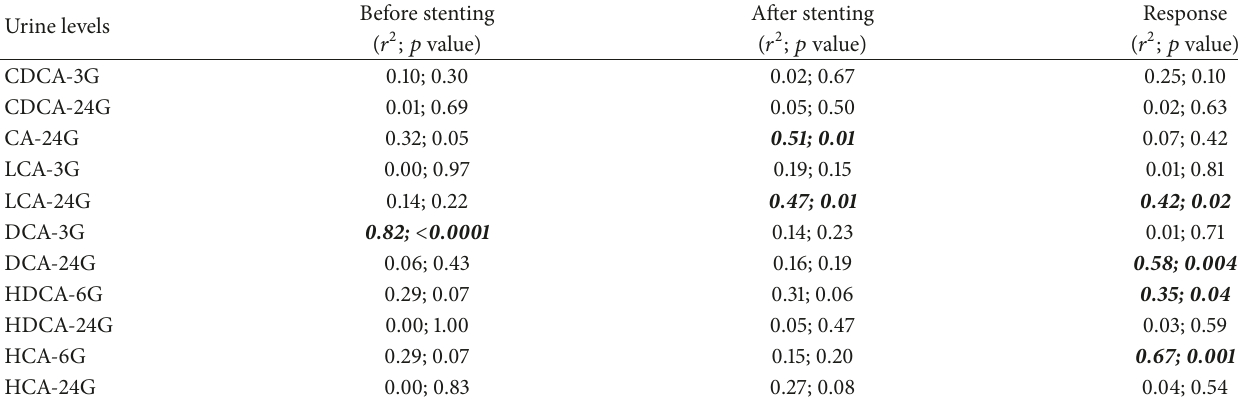
Table 1: Summary of the correlation studies between serum and urine bile acid-glucuronide profiles. Before Urine levels